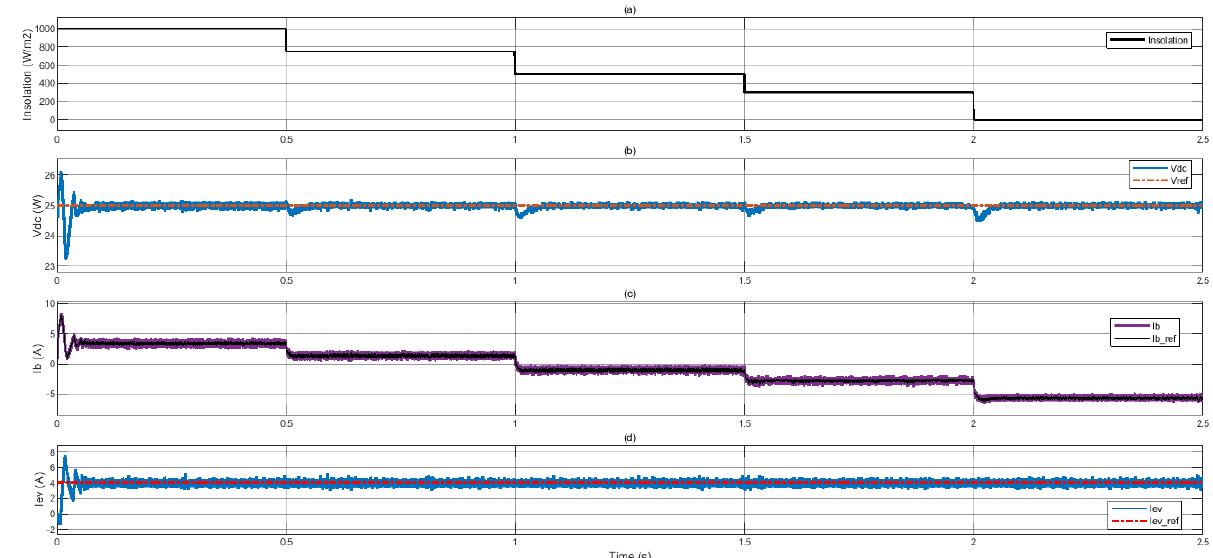
Figure 6. The system response with the fuzzy controller: ( a ) the sun insolation level, ( b ) the DC bus voltage, ( c ) the ESS battery current, and ( d ) the EV battery current.